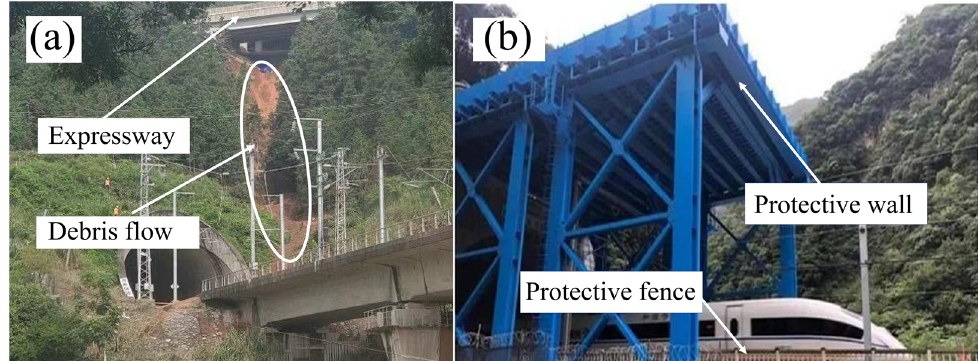
Figure 8. Safeguard: ( a ) Rongjiang Station tunnel exit; ( b ) protective facilities for Xi’an Chengdu Railway Construction to prevent rockfall.